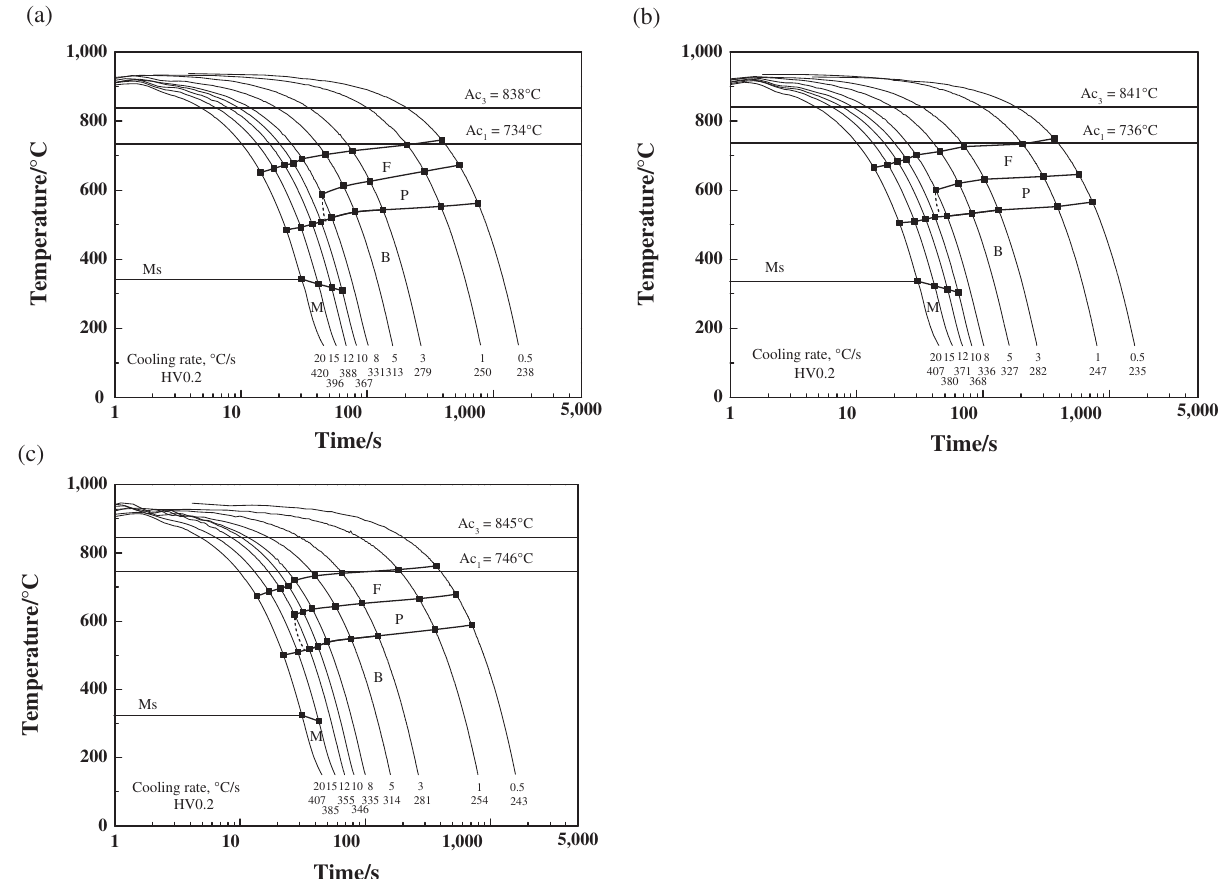
Figure 5: The dynamic continuous cooling transformation diagrams of the experimental steels: (a) VN1 (0.23 V – 0.019 N); (b) VN2 (0.22 V – 0.024 N); (c) VN3 (0.22 V – 0.034